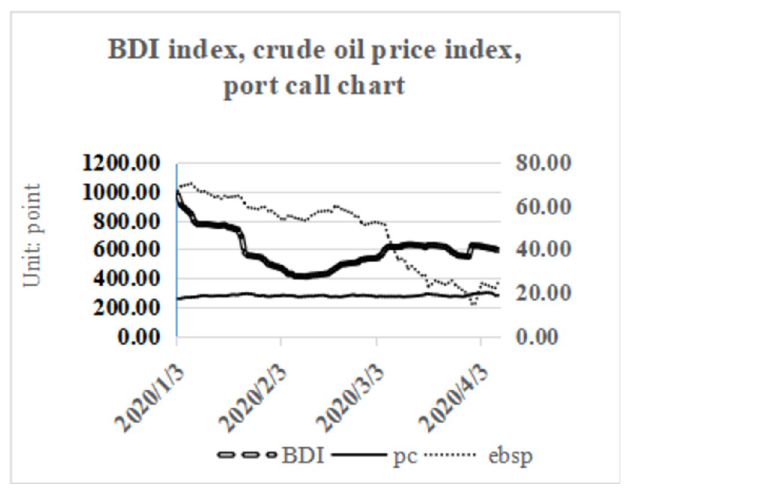
Fig 3. BDI index, crude oil price index, port linked trend